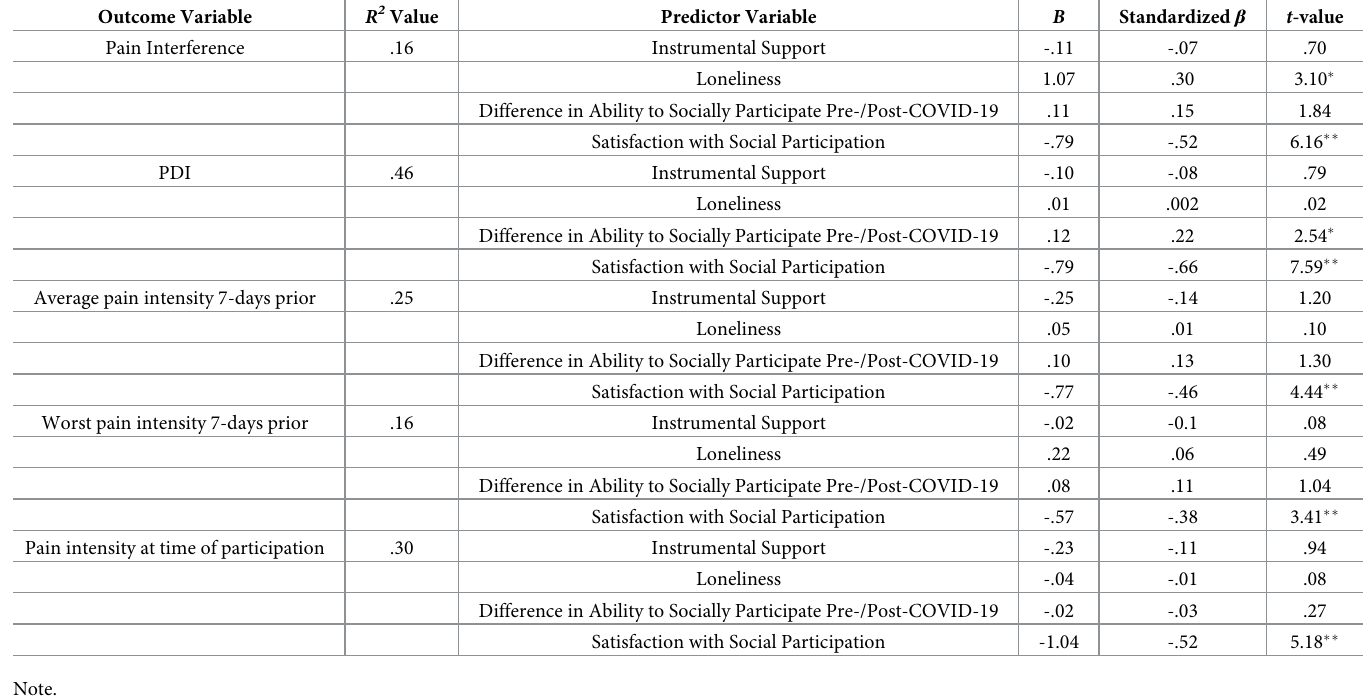
Table 3. Multiple linear regression values for all outcome and predictor